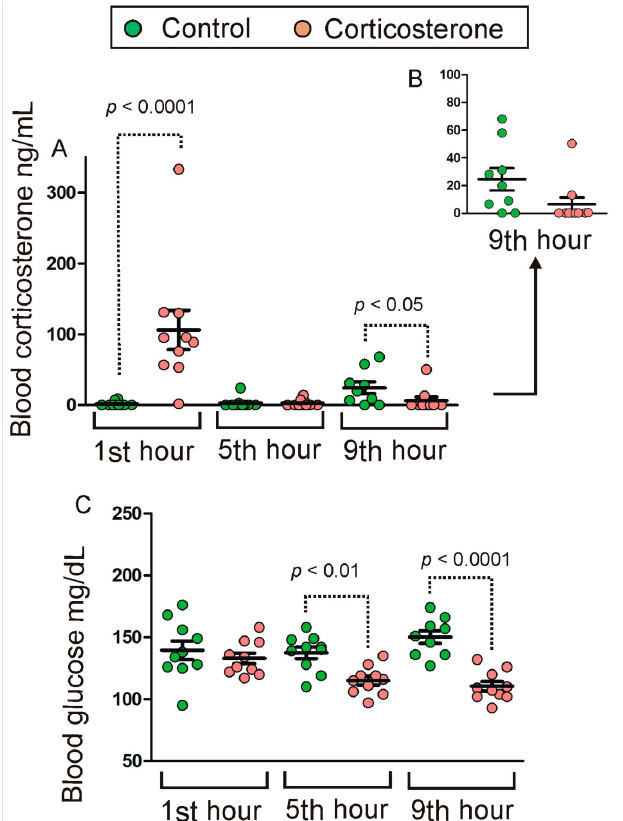
Figure 1. Effect of overnight corticosterone administered in drinking water on the blood level of corticosterone ( A , B ) and glucose ( C ) during the resting period occurring during the light phase. Data are presented as mean ± SEM overlayed on scatter plot of individual values. ( B ) part of data from panel ( A ) (ninth hour) shown with altered scale of Y